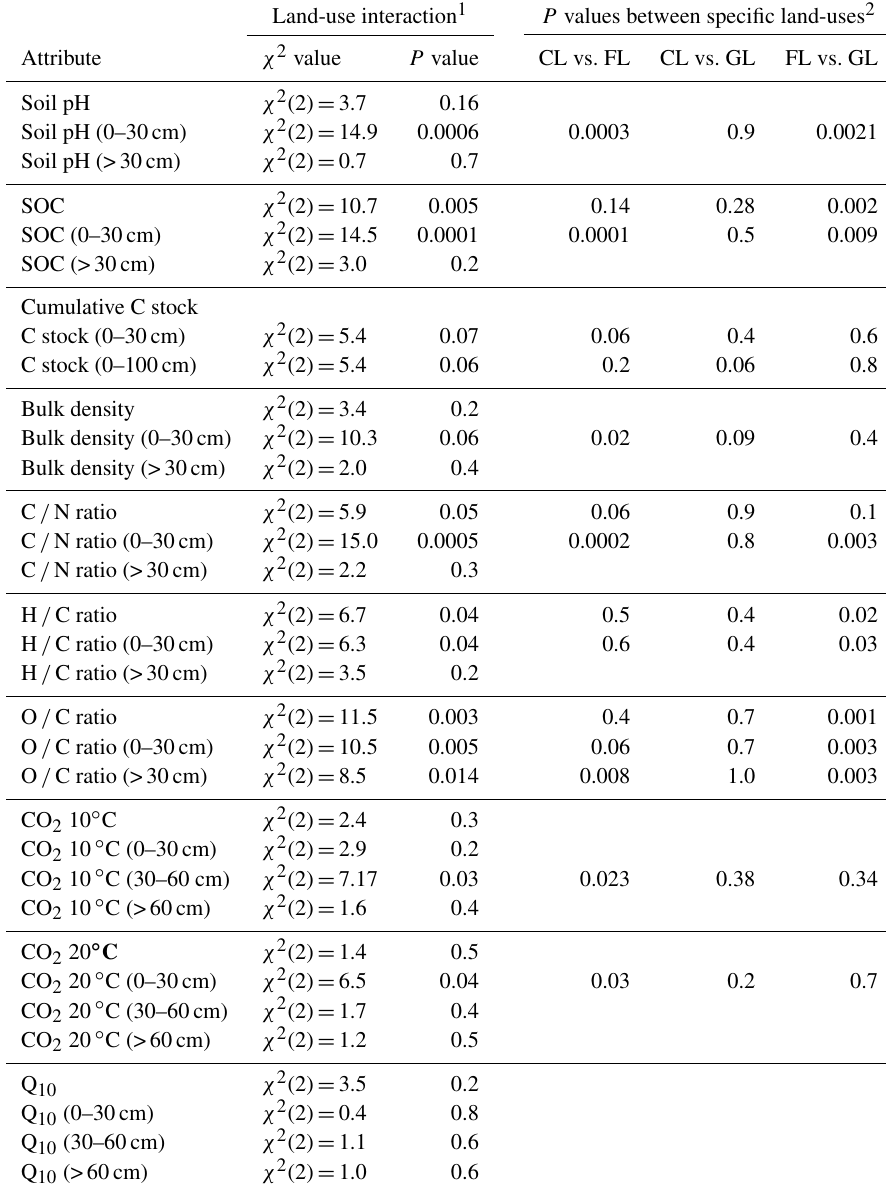
Table 2. Results of land-use effect analysis for the whole soil profile as well as specifically in the topsoil (0–30cm) and bottom layers (>30cm), displayed for SOC concentration, C stocks, bulk density C / N, H / C and O / C ratios, CO 2 emissions at 10 and 20 ◦ C and the resulting Q 10